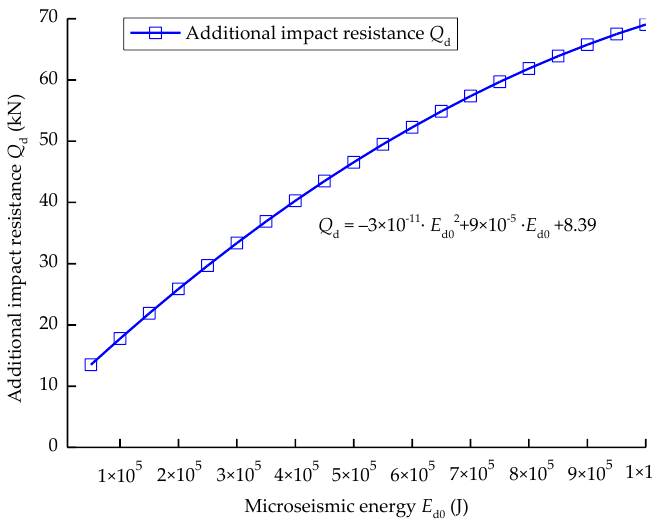
Figure 13. Relationship between microseismic energy E d0 and additional impact resistance Q d .